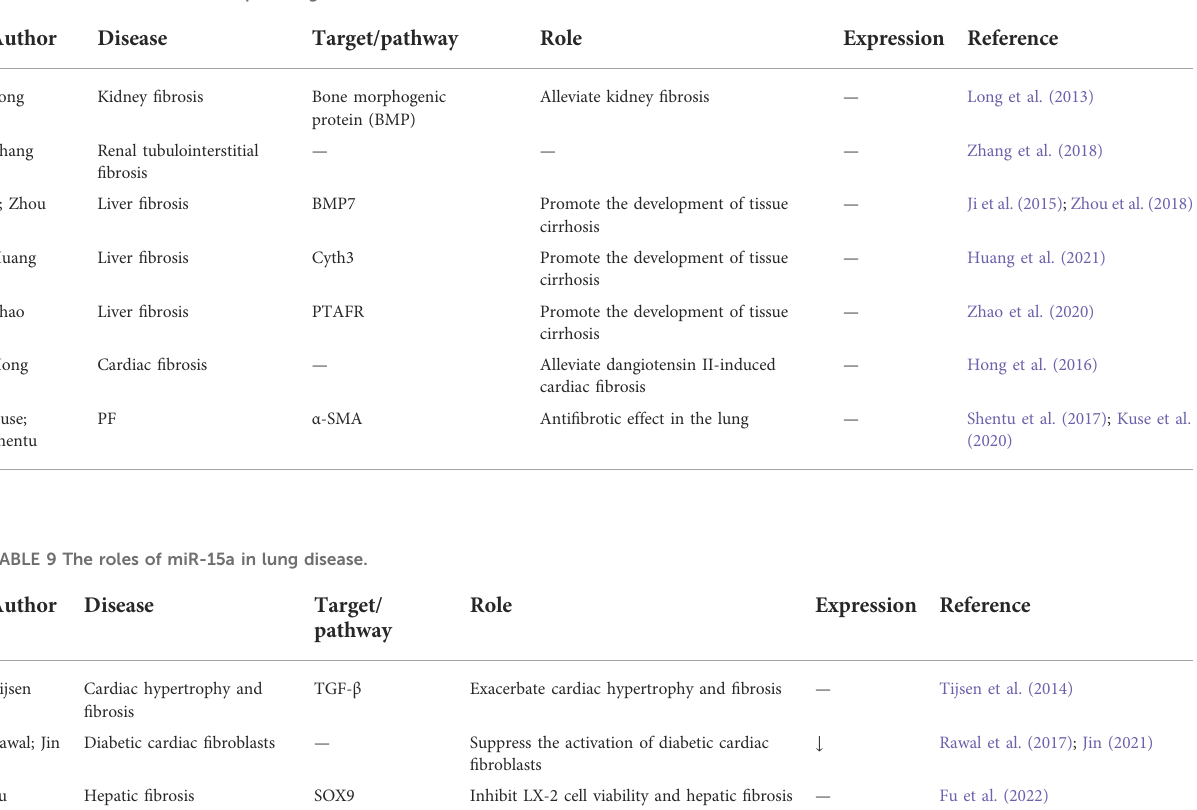
TABLE 8 The roles of miR-22-3p in lung disease.